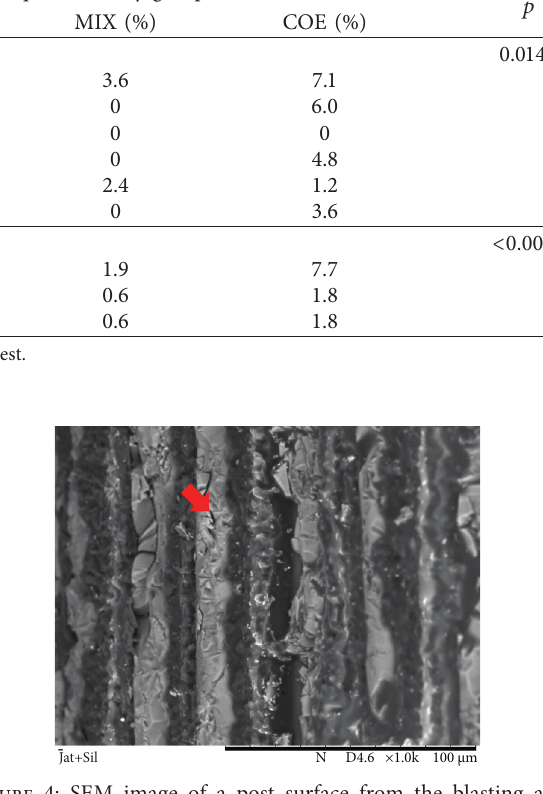
Figure 2: SEM image of a post surface from the control group (1000x magnification). Areas of intact fibers are visible, but dis- continuity is present (arrow).